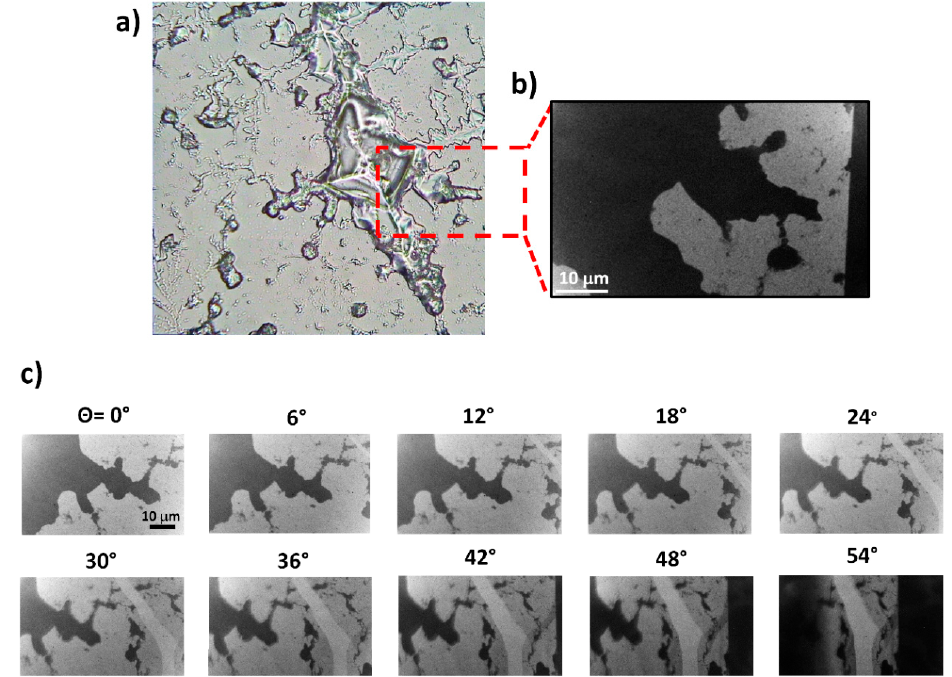
Figure 22. HEp-2 cells (human larynx epidermoid carcinoma cell line) in phosphate-buffered saline (PBS) medium on top of a 30 nm thick membrane. ( a ) Shows an optical microscope picture (visible light) acquired with a 40× objective. ( b ) Shows the region of the membrane imaged in SXR, which was then acquired at different angles with the SXR tomographic system. ( c ) From the 12° projection, it is